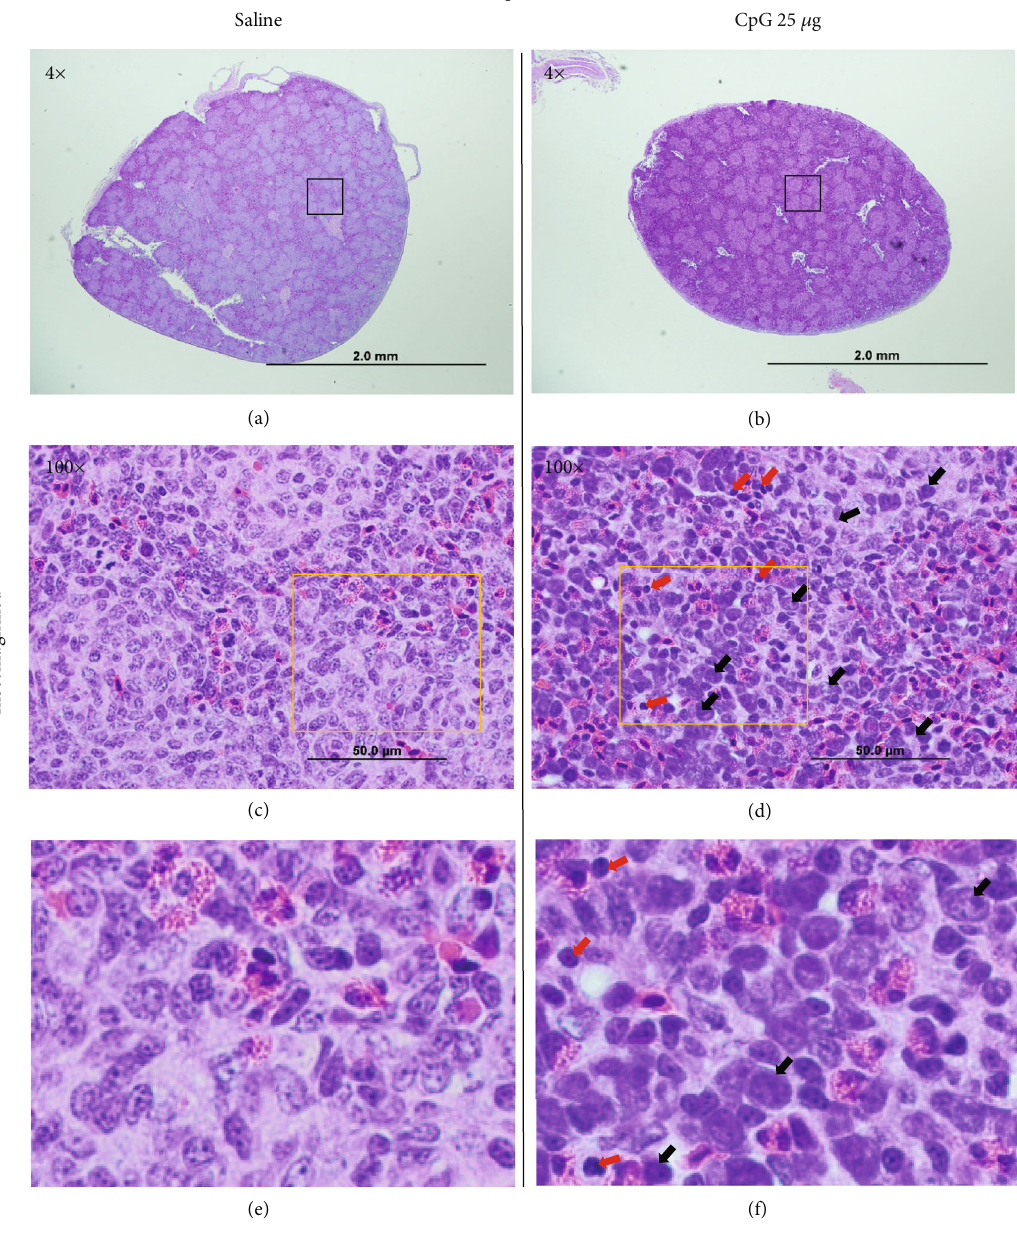
Figure 4: Histology of the spleen. Hematoxylin and eosin staining 72 hrs post in ovo injections revealed higher cellular in fi ltration in the spleen of birds treated with 25 μ g CpG-ODN compared to saline control. Higher cellular in fi ltration was seen with CpG-ODN treatment (b) compared to saline (a) in low power (4x). High power magni fi cation (100x) (d) and the magni fi ed inset (f) showed that these cells mainly comprised of a mononuclear (macrophages) cell population (black arrows) and lymphocytes (red